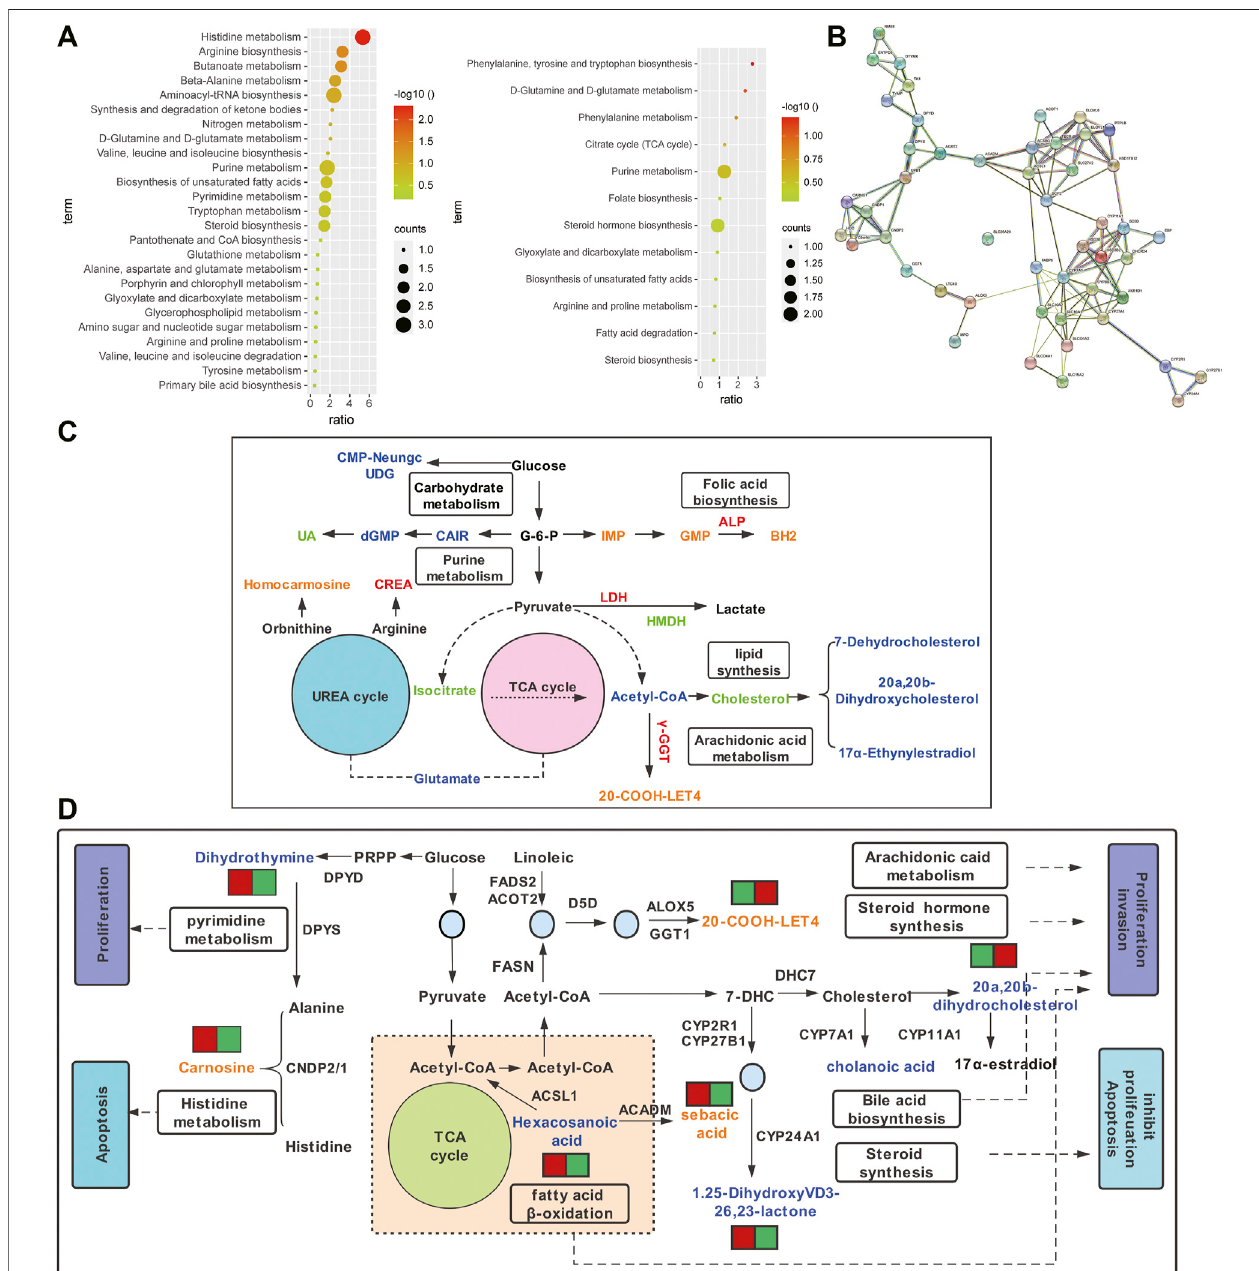
FIGURE 5 | Pathway analysis of differential metabolites between ovarian cancer tissue and ascites. (A) Enrichment pathway bar chart of differential metabolites in non-chemotherapy group vs chemotherapy group (left) and chemotherapy-sensitive group and chemotherapy-resistant group (right) . (B) The shared pathways involved in differential metabolites and serological indicators. Orange or blue represent up-regulated or down-regulated differential metabolites, respectively. Red or greenrepresent up-regulated ordown-regulated serologicalindexes, respectively. (C) NetworkviewofSTRING analysisofgenesrelated todifferentialmetabolites ( p < 0.001). (D) Proposed metabolic mechanisms associated withovarian cancer.Red font represents the non-chemotherapygroup and chemotherapygroup, whichis mainly involved in histidine metabolism and fatty acid β oxidation, promoting apoptosis and inhibiting metastasis. Blue font represents the chemotherapy-sensitivity group and chemotherapy-resistant group, which are mainly involved in lipid metabolism, promoting tumor proliferation and metastasis, and the occurrence of drug resistance. denote